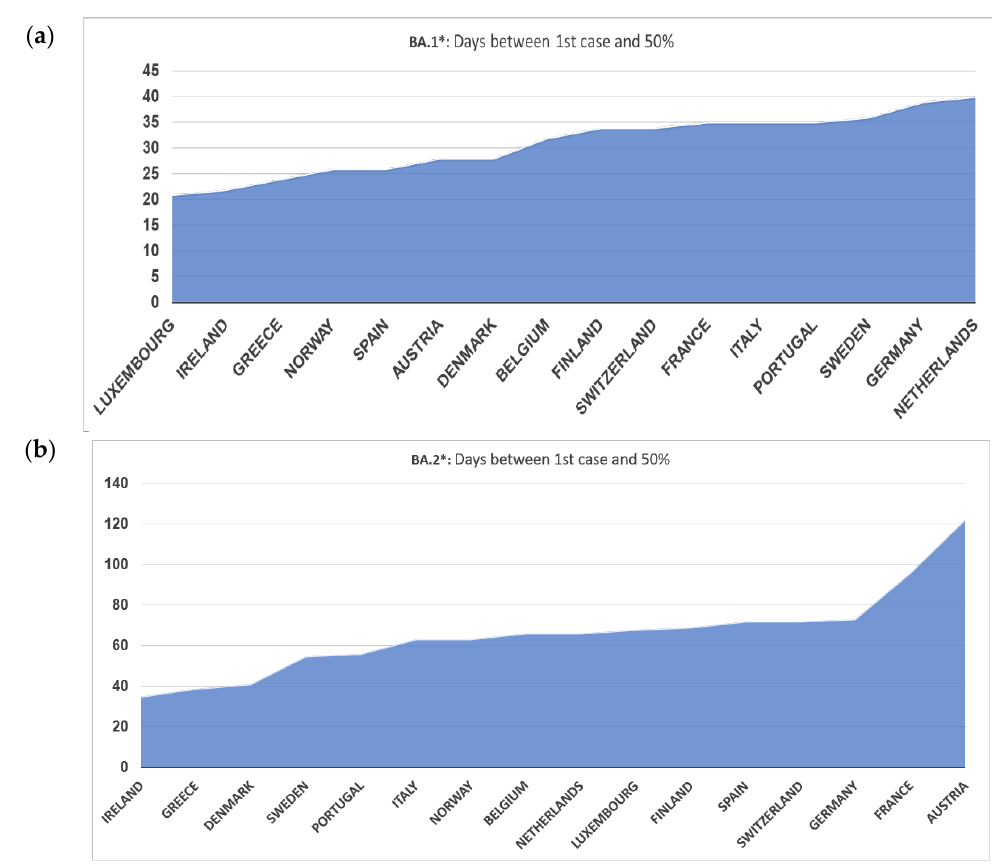
Figure 3. Days between first case and proportion of at least 50% of all samples ( a ) BA.1* variants ( b ) BA.2*